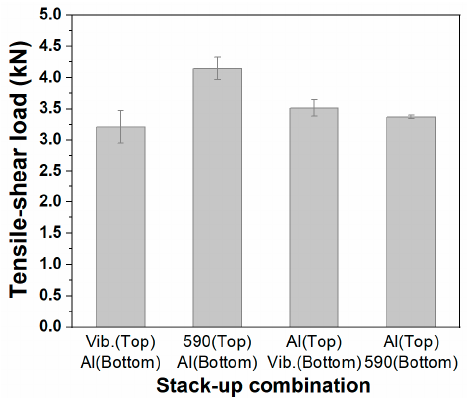
Figure 16. Comparison of tensile–shear loads of SPR joint (fabricated by type A1 die) for different stack-up combinations.